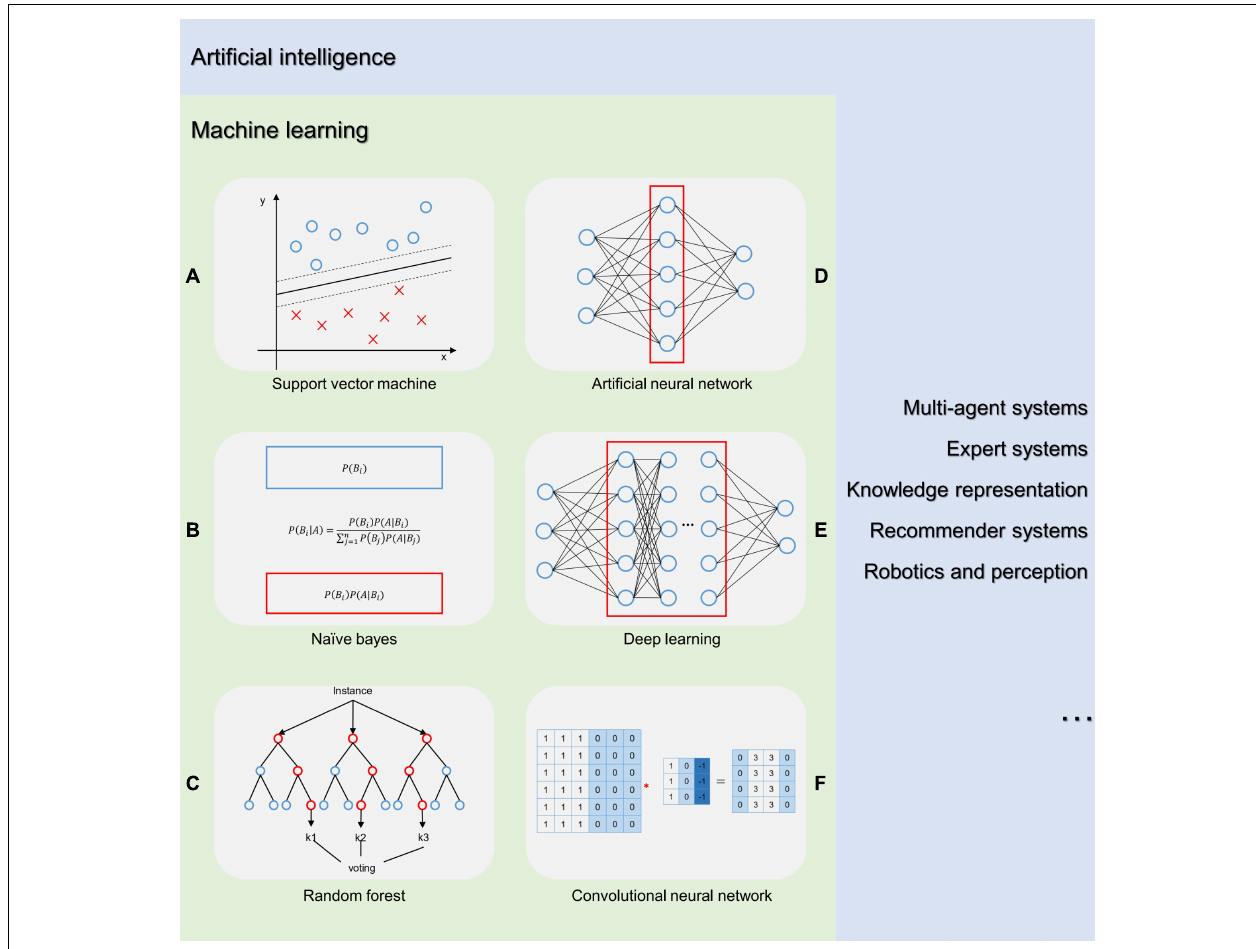
FIGURE 2 | Artificial intelligence terminology. AI is a general term concerning the computer science that enables the machine applying the human intelligence such as “learning” and “problem-solving” to perform the practical task. ML, multi-agent systems, expert systems, knowledge representation, recommender systems, robotics, and perception are the subset of AI. ML is a subset of AI, which automatically detects patterns in data to make predictions or decisions without explicitly being programmed. (A) Support vector machine (SVM) is a discriminative classifier that has an excellent performance in classification due to its strength of regularization and convex optimization. With the application of “kernel trick,” SVM can handle non-linear problems. (B) Naïve Bayes is a probabilistic ML algorithm based on the Bayes’ theorem and assumes the independence between features. (C) Random forest is an ensemble algorithm constructing numerous decision trees at training to increase the overall result by combining learning models. (D) Artificial neural network (ANN) is a regression and classification algorithm composed of artificial neurons applying simple classifiers to output decision signals based on the weighted sum of evidence. The basic structure was the combination of an input, hidden connection, and output layer. (E) Deep learning is a class of ANNs with several hidden layers which can learn complex hierarchical representations from the data for feature extraction and transformation, and for pattern analysis and classification. (F) Convolutional neural network (CNN) is a specific subset of ANNs that imitate the organization of the animal visual cortex for image processing tasks. The convolutional layer of CNN is the essential